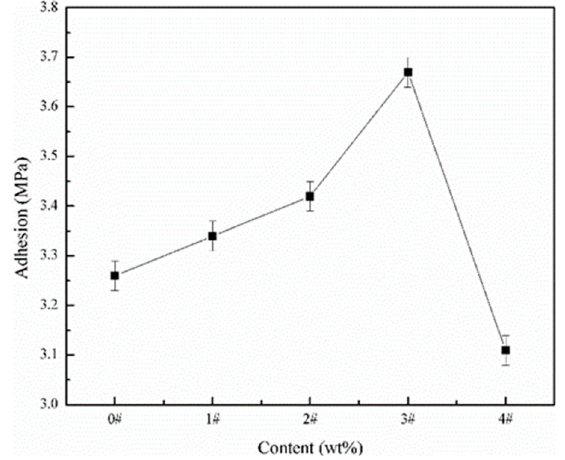
Figure 4. Adhesion of di ff erent SHWPUCs to the steel substrates.